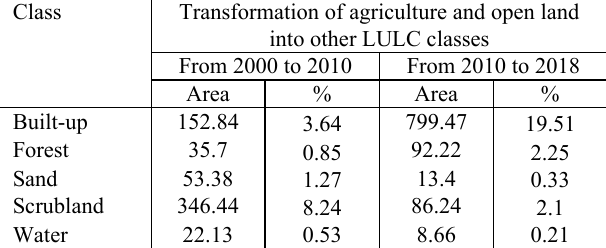
Table 5. Agriculture and open land transformation into other LULC classes. All values of area are in km 2